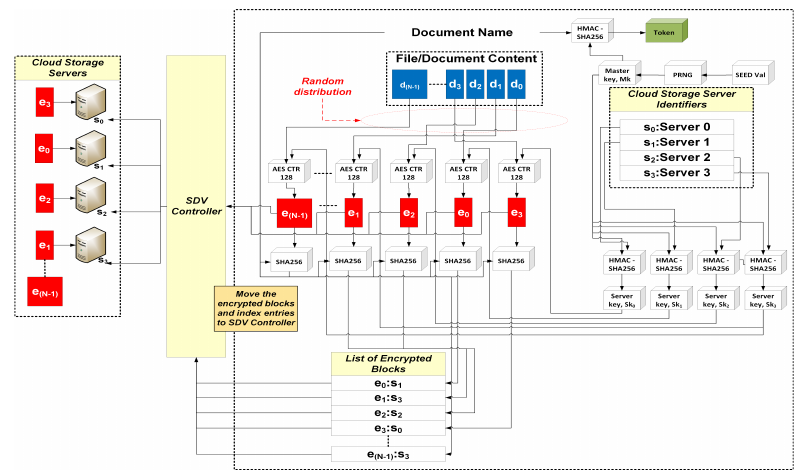
Figure 5. SDV API: How document submission is performed (e.g., given four cloud storage servers). AES-CTR: Advanced Encryption Standard in counter mode.